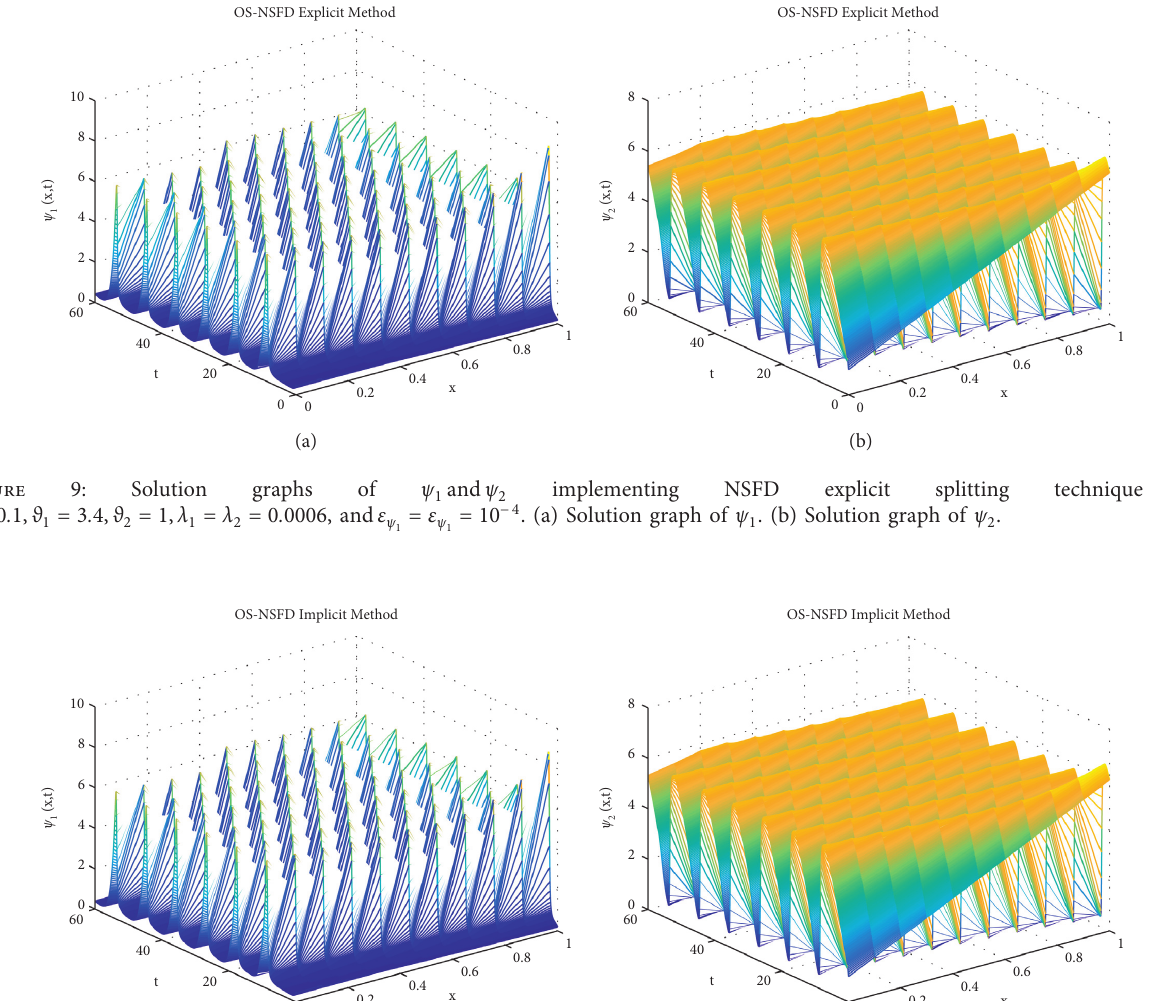
and ψ implementing NSFD implicit splitting method 1 2